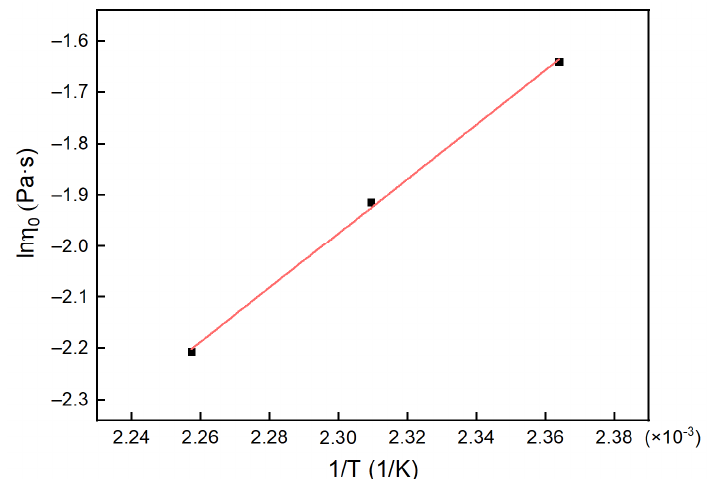
Figure 17. The fitting line for the η 0 of the H 6 XDI/BES system. Entering the data from Figure 17 into Equation (21), we obtained E (cid:2967) = 44.137 kJ/mol and η (cid:2998) . =3.539*10 − 7 . The η (cid:2868) of the system was expressed as follows: